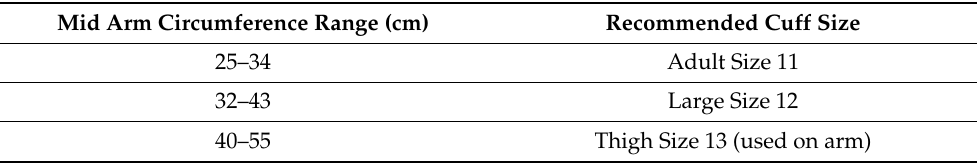
Figure 1. The Welch Allyn adult Size 11 cuff. The artery index marker should be situated between the white marker range (25 – 24 cm) once wrapped around the arm, to ensure correct sizing. Table 1. Recommended noninvasive blood pressure cuff size as determined by mid-arm circumfer- ence and recommended by Welch Allyn